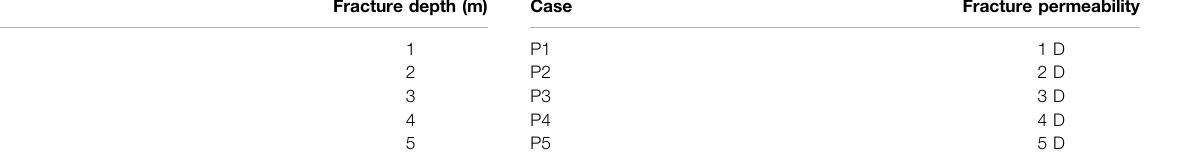
TABLE 2 | Fracture depth and corresponding calculation case. Case Fracture depth (m)